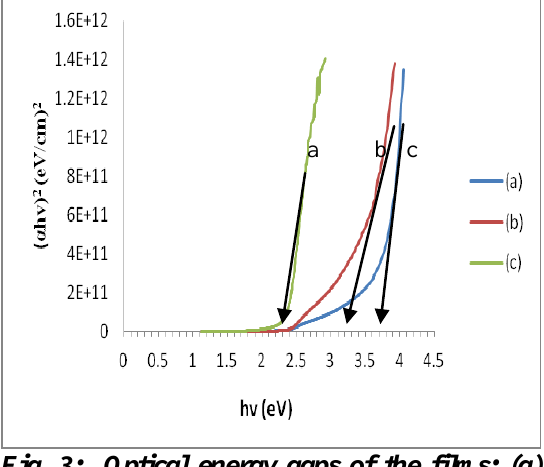
Fig. 3: Optical energy gaps of the films; (a) one deposition (b) double deposition and (c) triple deposition.